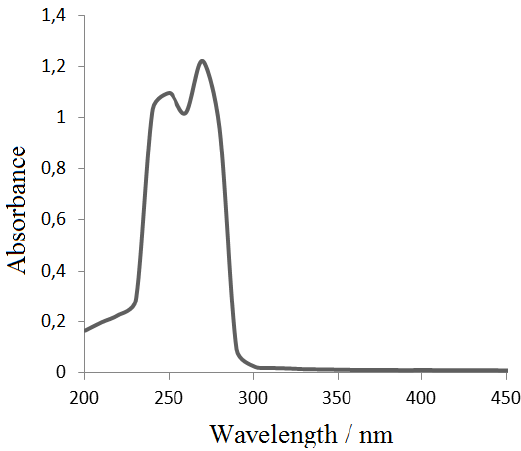
Figure 4. The UV-Vis spectrum of the hydroxyethyl-substituted Ag-NHC complex 1.